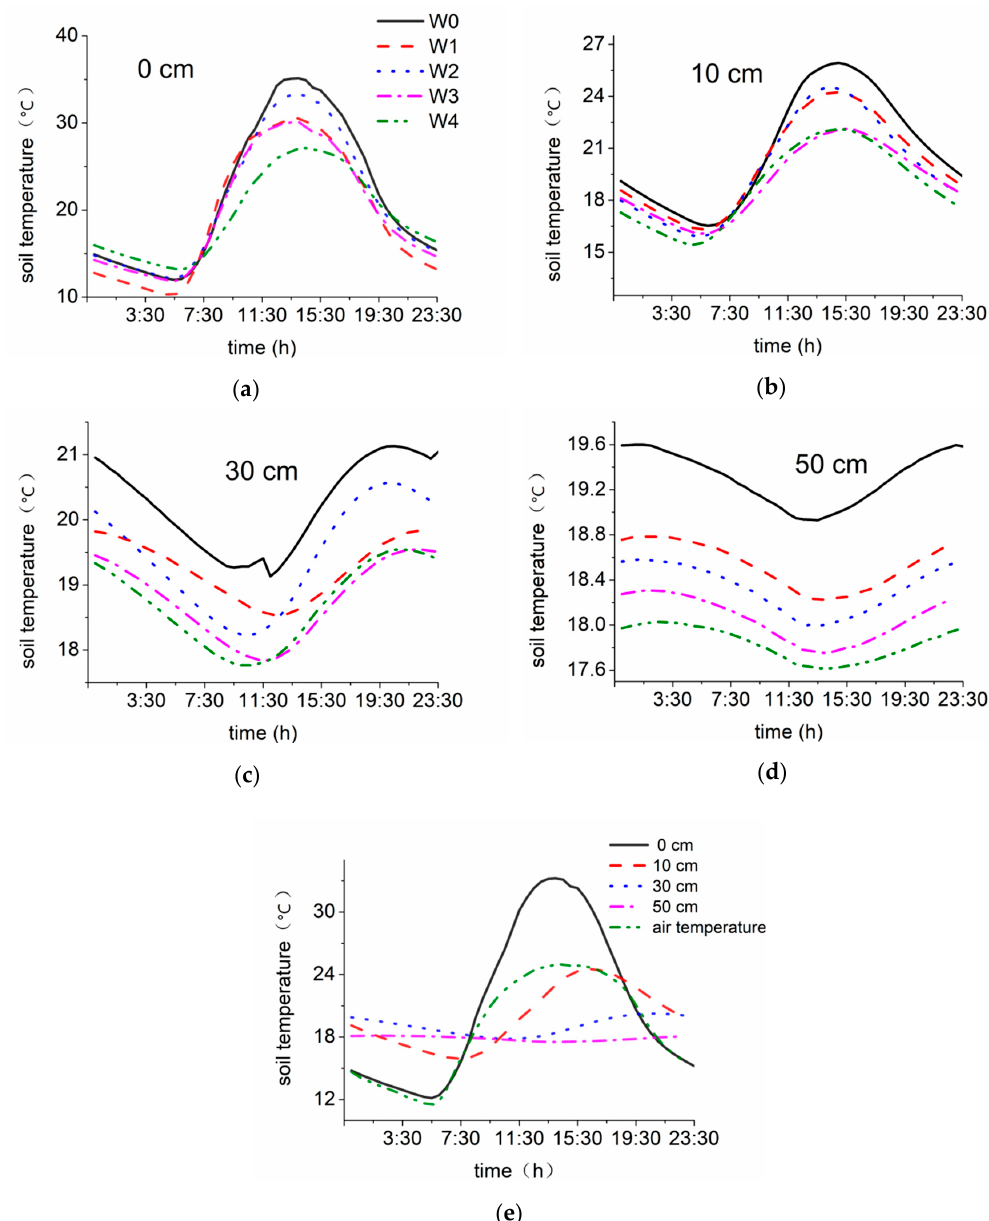
Figure 3. The diurnal variation of soil temperature ( a ) on the soil surface, ( b ) at the depth of 10 cm, ( c ) at the depth of 30 cm, ( d ) at the depth of 50 cm, ( e ) at different depths.